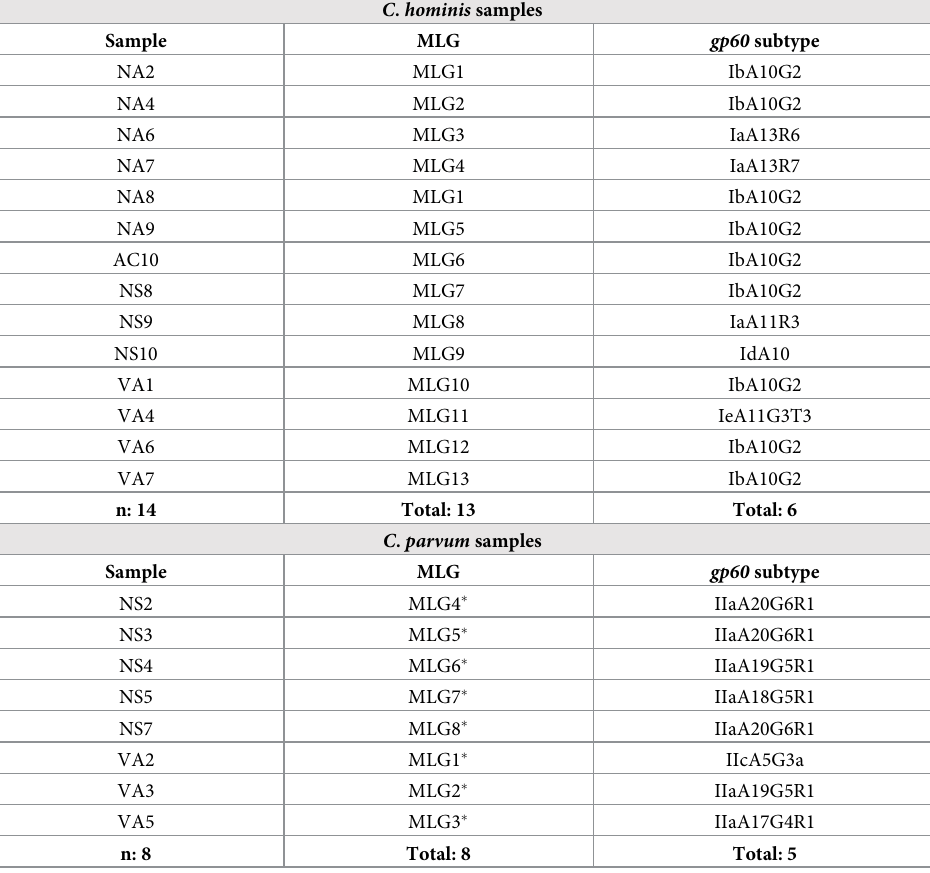
Table 3. MLG based on the CS for C . hominis and C . parvum parasites identified in Colombian